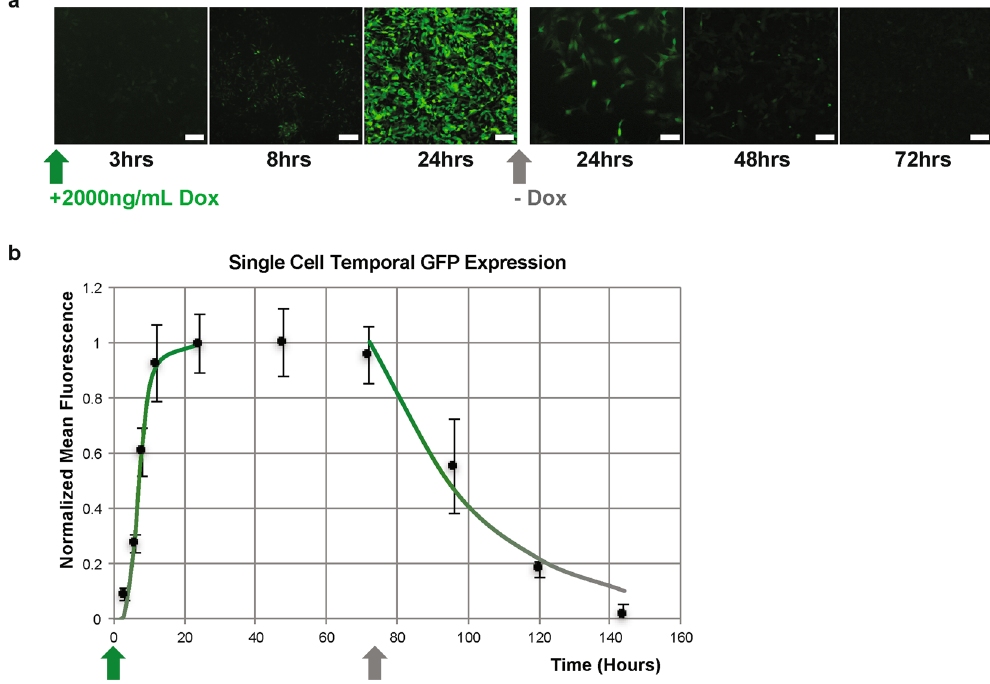
Figure 2. Characterization of XLone temporal expression pattern. ( a ) Fluorescence microscopy images showing the change in GFP expression over time with and without doxycycline. Scale bars are 100 µ m. ( b ) Plot illustrating the normalized average corrected total fluorescence of a single cell over time as GFP expression turns on, reaches a steady state maximum, and turns off. The non-linear curve fits are described by the on and off rate equations and the error bars show standard error of the